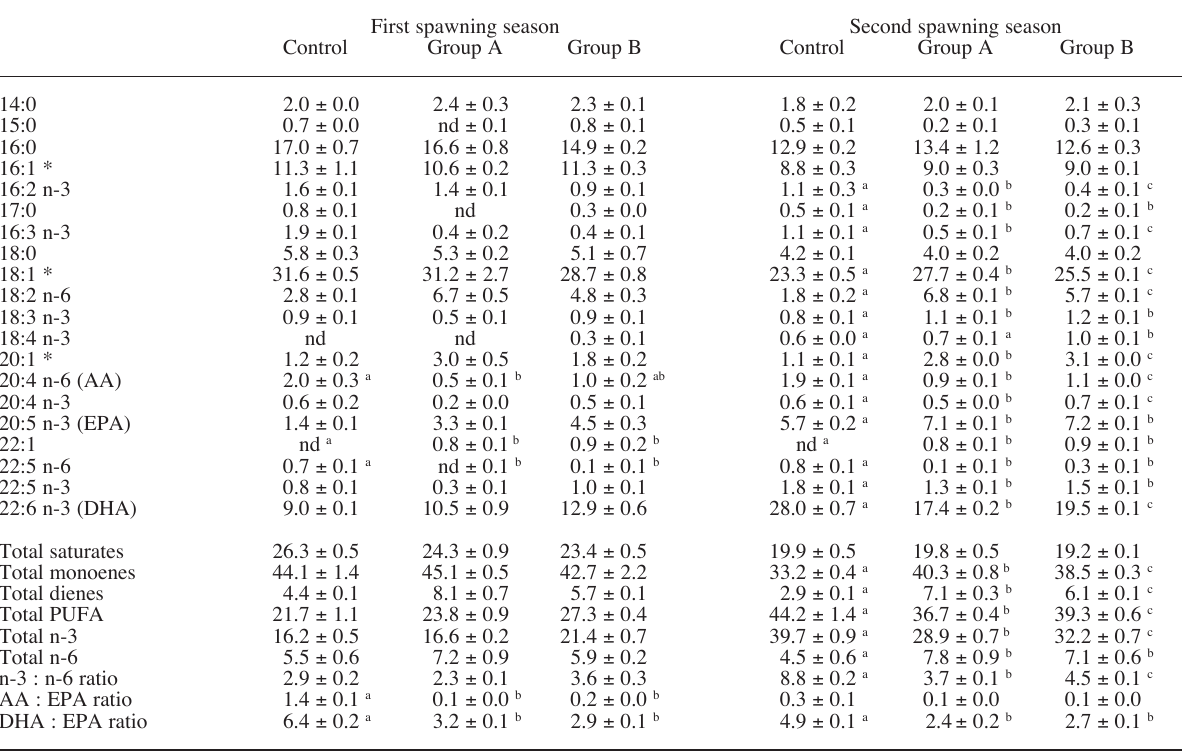
T ABLE 6. – Fatty acid composition of the total lipid extracted from fertilised eggs of sea bass reared on different diets during the first and sec- ond spawning seasons. Significant differences (p<0.05) between fatty acid concentrations in the eggs of different groups into a particular spawning season were signalled by different superscripts (a, b and c). Means with superscript 'a' are significantly different from means with superscript 'b' and from means with superscript 'c'. In the same way, means with superscript 'ab' are not significantly different from means with superscript 'a' or from means with superscript 'b'. If no significant differences were found, no superscripts are